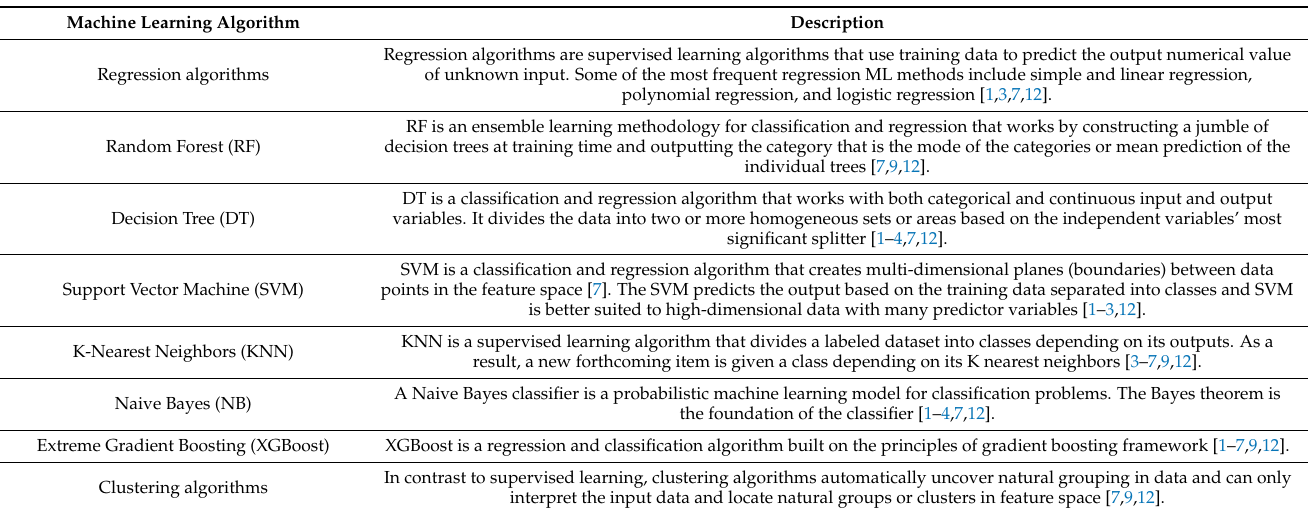
Table 1. Machine learning